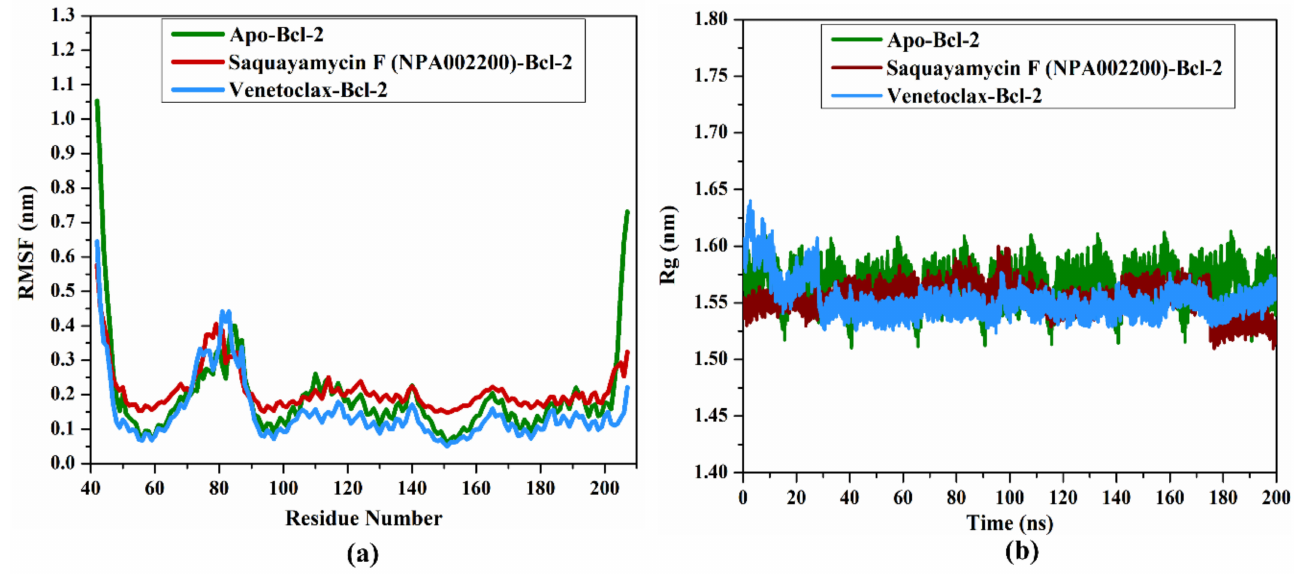
Figure 9. ( a ) RMSF of the C α atoms and ( b ) Rg of apo- and inhibitor-soaked Bcl-2 protein during 200 ns MD course. Color Scheme: Apo-Bcl-2 protein (in green), saquayamycin F-Bcl-2 (in dark red), and venetoclax-Bcl-2 (light blue).